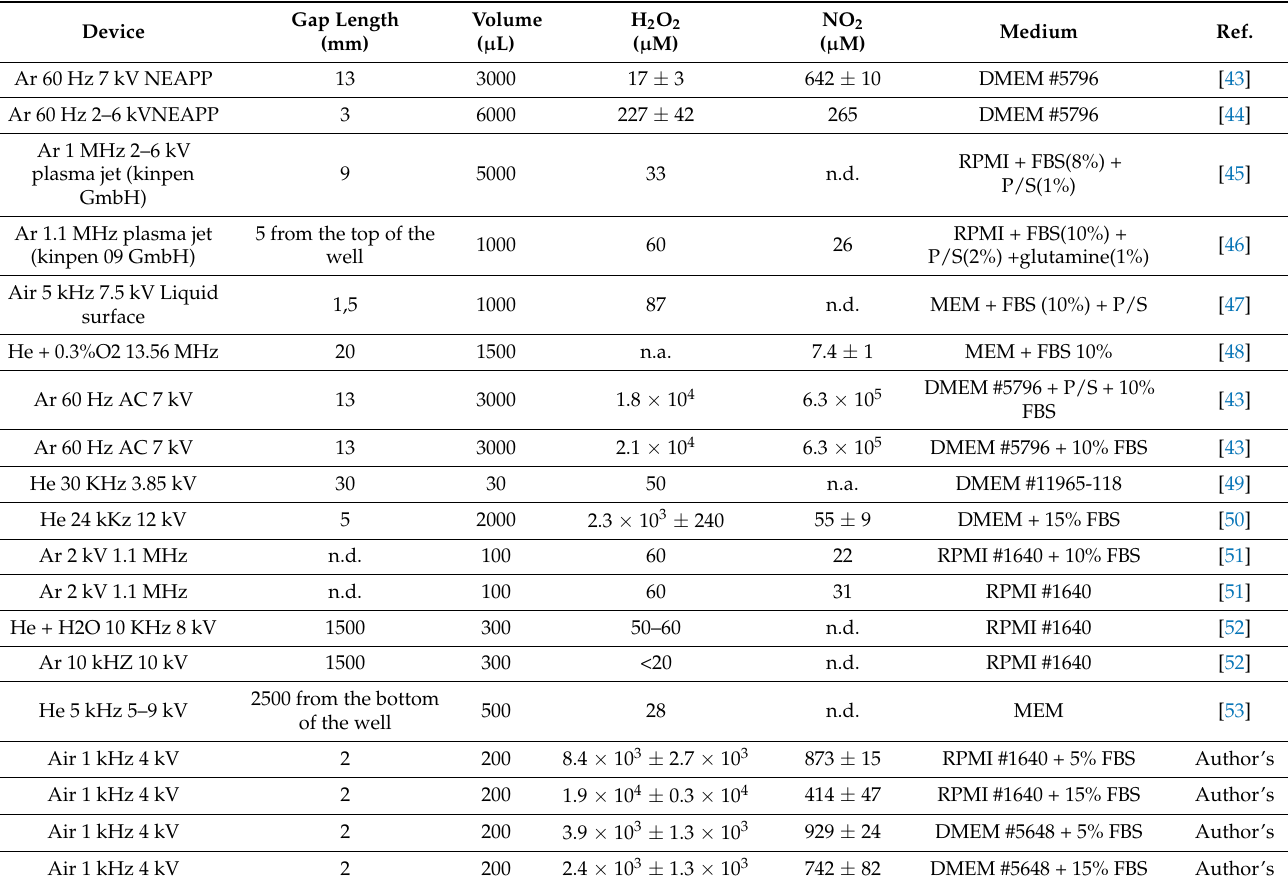
Table 2. Concentration of H 2 O 2 and NO 2 generated by 60 s plasma compared with other plasma